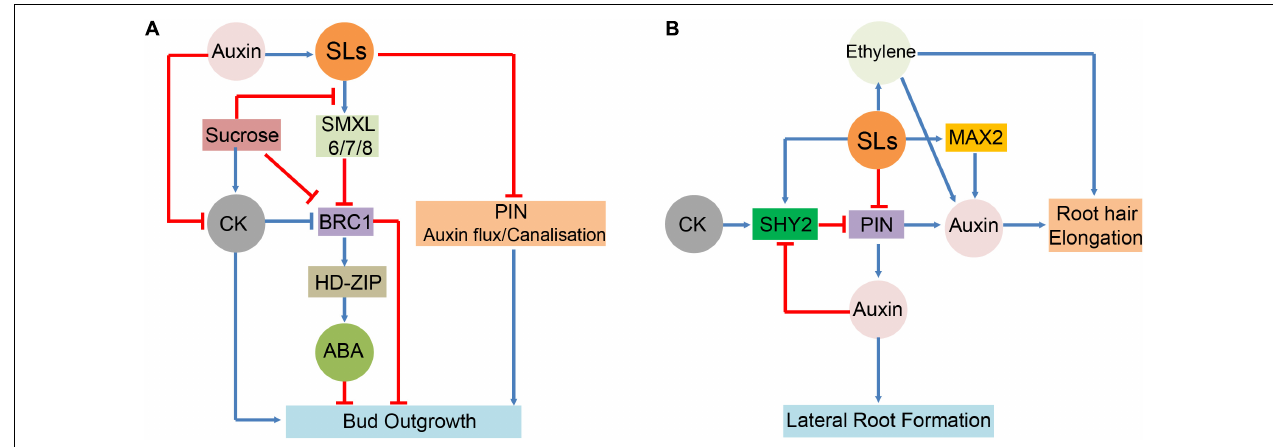
FIGURE 3 | Interactions between SLs and hormones in major growth and developmental process. (A) : SLs functions and interactions with ABA, auxin, and CK in the regulation of bud outgrowth. (B) : Involvement of SLs in the hormonal control of lateral root and root hair (RH). signify inhibitory effect; signify stimulatory effect. TABLE 1 | Effects of strigolactones and hormones crosstalk on various plant species. Plant